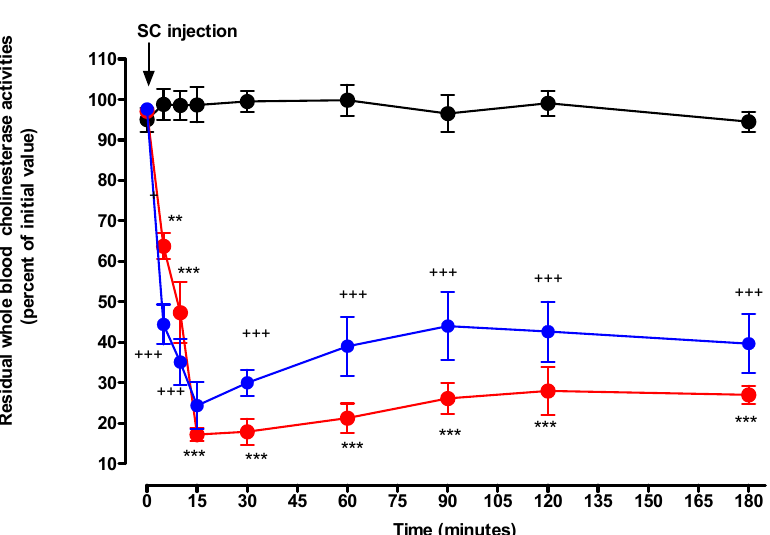
Figure 6. Time-courses of residual whole blood cholinesterase activities in control (black circle), DMPO 50% MLD50 (blue circle), and DEPO 50% MLD50 (red circle) treated groups. Control group consisted of two rats and treated groups of three rats. Arrow denotes the time of injection of solvent, DMPO, or DEPO. Data are represented by mean ± SEM at each time after injection. DMPO vs. control: + p < 0.05, ++ p < 0.01, and +++ p < 0.001. DEPO vs. control: * p < 0.05, ** p < 0.01, and *** p < 0.001.